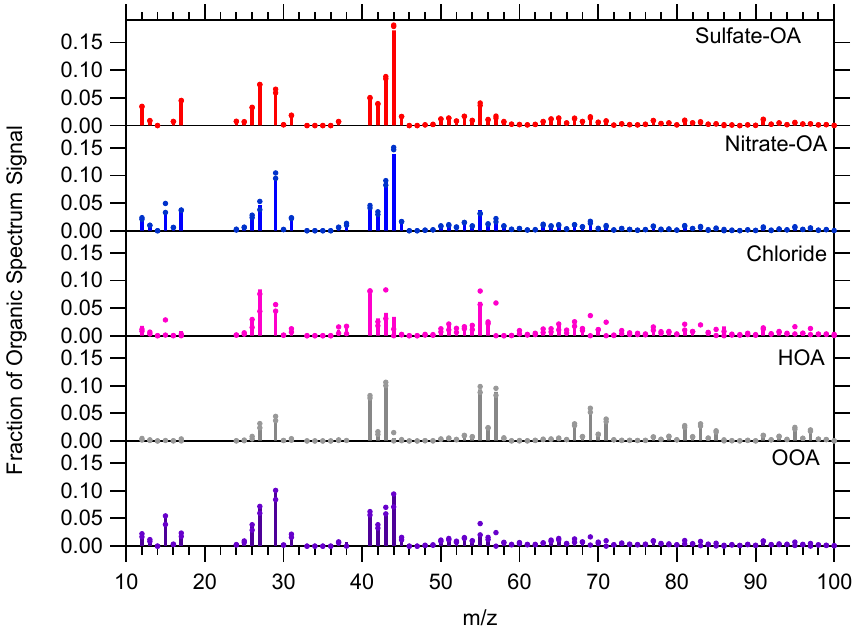
Figure 6. Mass spectra of the organic fraction of the factors from the six-factor solution from PMF Full MS analysis. The Amine factor is not shown due to insufficient information regarding the chemical nature of the Amine factor. Bars represent the central, chosen rotation, and dots show the range in mass spectral variation from FPeak rotations ( − 10 and